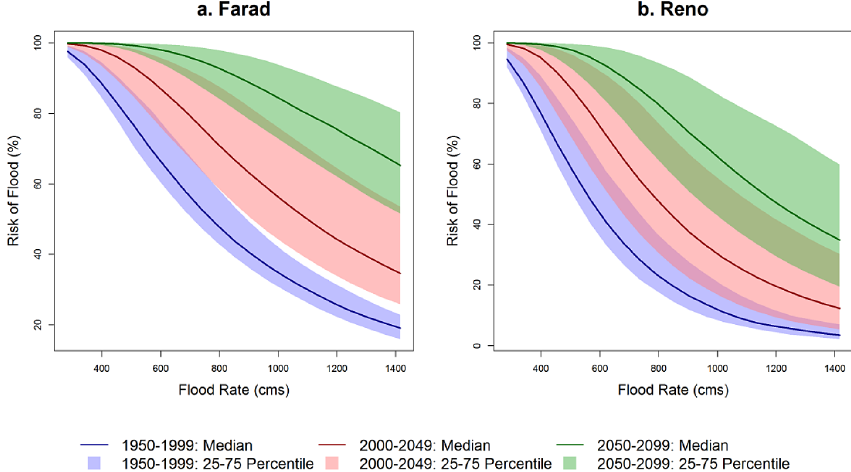
Figure 8. Probability of flood in a 10-year project life (risk) vs. median 1-day flood rate at (a) Farad and (b) Reno for three time periods 1950–1999 (blue), 2000–2049 (red) and 2050–2099 (green). Solid lines represent the median of the 234 climate projections and shading covers the interquartile range (i.e., 25th to 75th